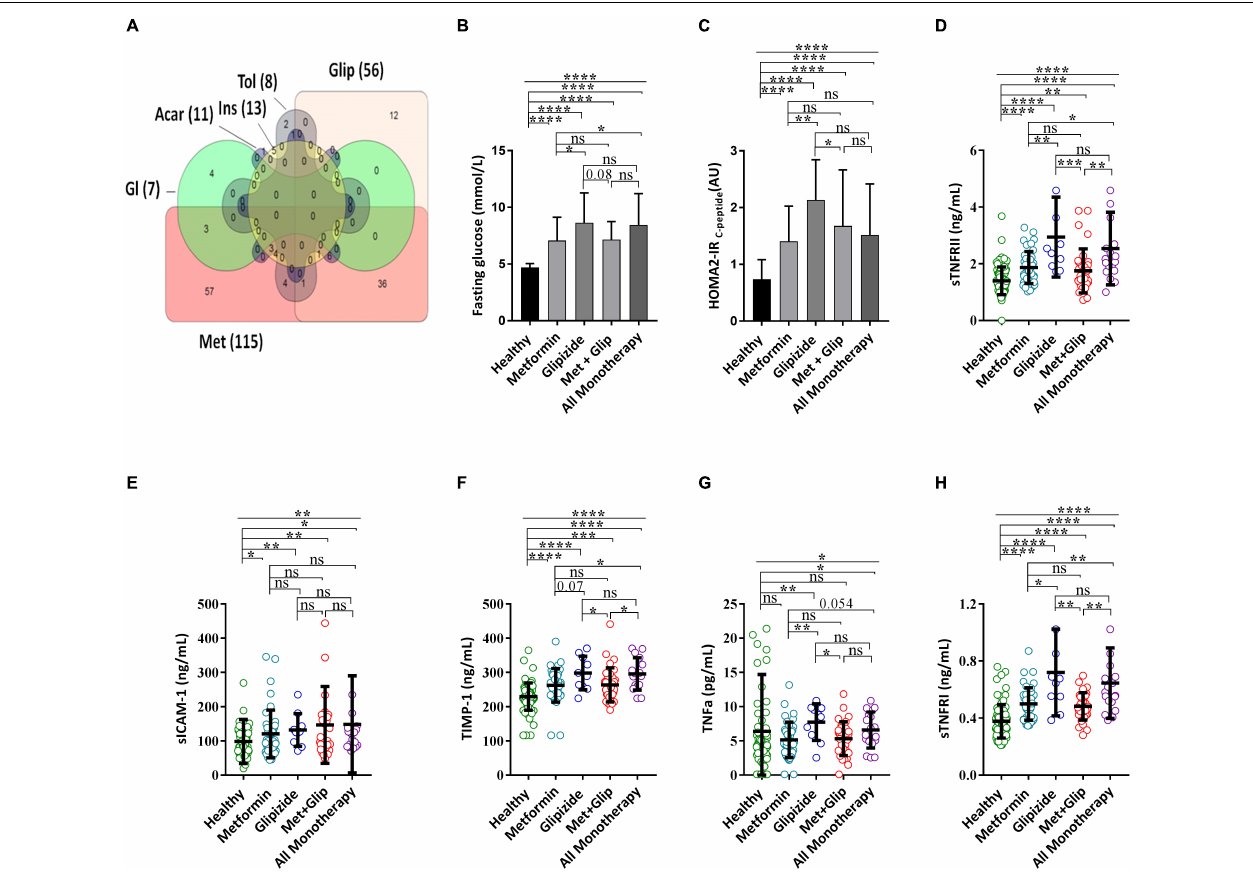
FIGURE 5 | Metformin decrease TNF α associated Systemic Inflammatory molecules. (A) Venn diagram [made using online free software (Bioinformatics and Evolutionary Genomics, 2017)] indicates the combination of drug used for a total of 140 diabetes patients (1 patient take a combination of gliclazide and diabetin is not included in the Venn diagram). Comparison of DM patients with different treatments for fasting blood glucose (B) , HOMA2-IR C − peptide (C) , sTNFRII (D) , sICAM-1 (E) , TIMP-1 (F) , TNF α (G) , and sTNFRI (H) . P -values were calculated using non-parametric Kruskal–Wallis test and Mann–Whitney U -test was used for comparing more than two groups and between two groups, respectively (ns P > 0.05, ∗ P < 0.05, ∗∗ P < 0.01, ∗∗∗ P < 0.001, ∗∗∗∗ P < 0.0001). Acar, acarbose; Glip, glipizide; Gl, glibenclamide; Ins, Insulin; Tol, tolbutamide; Met, metformin.